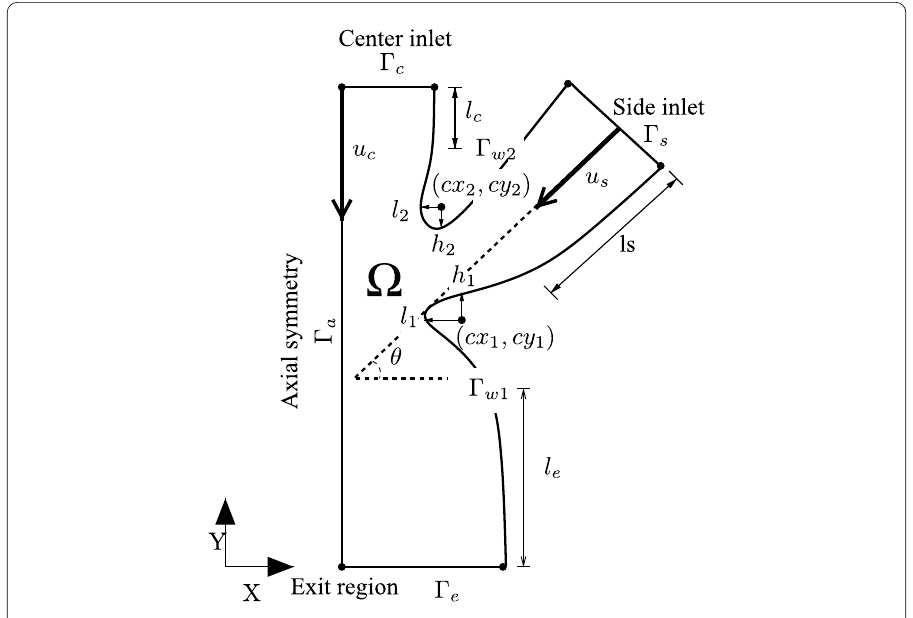
Figure 2 Domain (cid:2) 2 D , q and parametrization of the mixer considered when solving the optimization problem